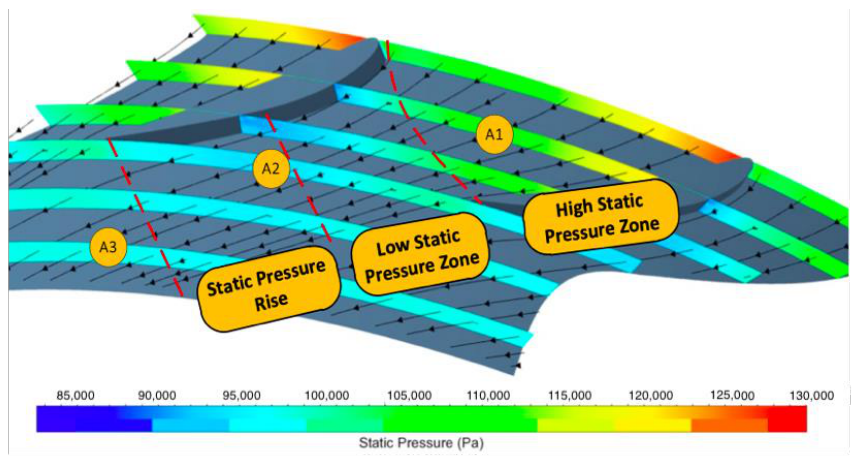
Figure 12. Static pressure distributions of different sections in the high-reaction tip turbine.